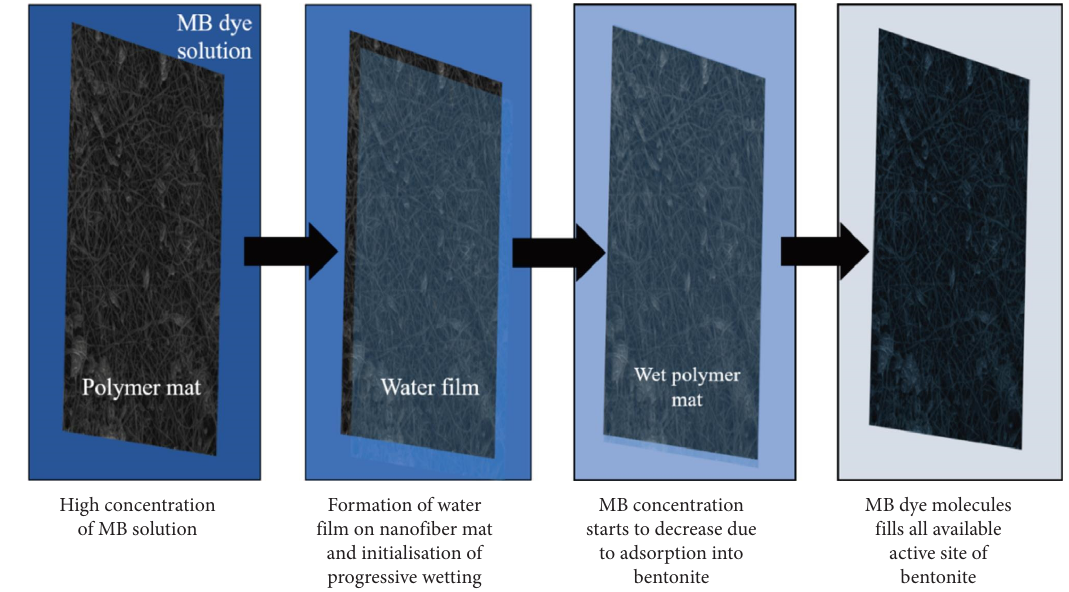
Figure 6: Visual evidence of the adsorption of methylene blue dye on the PVB/bentonite nanofber